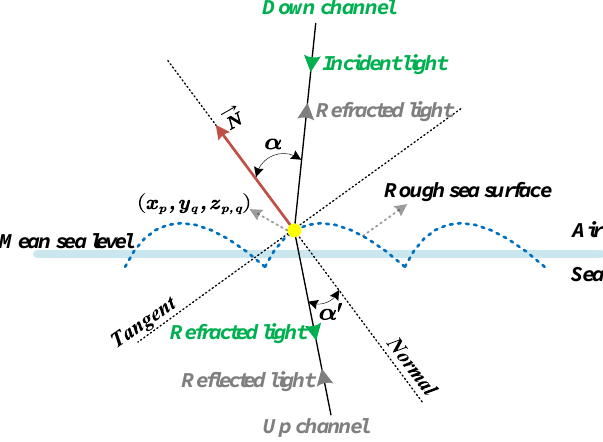
Figure 8. Schematic diagram of the light path of the down channel and the up channel. (cid:16) (cid:17) x p , y q , z p , q In Figure 8, is a mesh node inside the pulse spot on the interface, as the same incident point of the laser light lines along the down channel and up channel respectively; For the down (cid:48) channel, α represents the angle of incidence, and α represents the angle of refraction; On the contrary, α represents the angle of refraction and α (cid:48) represents the angle of incidence for the up channel. We can analysis the transmittance based on α which can be obtained by Equation